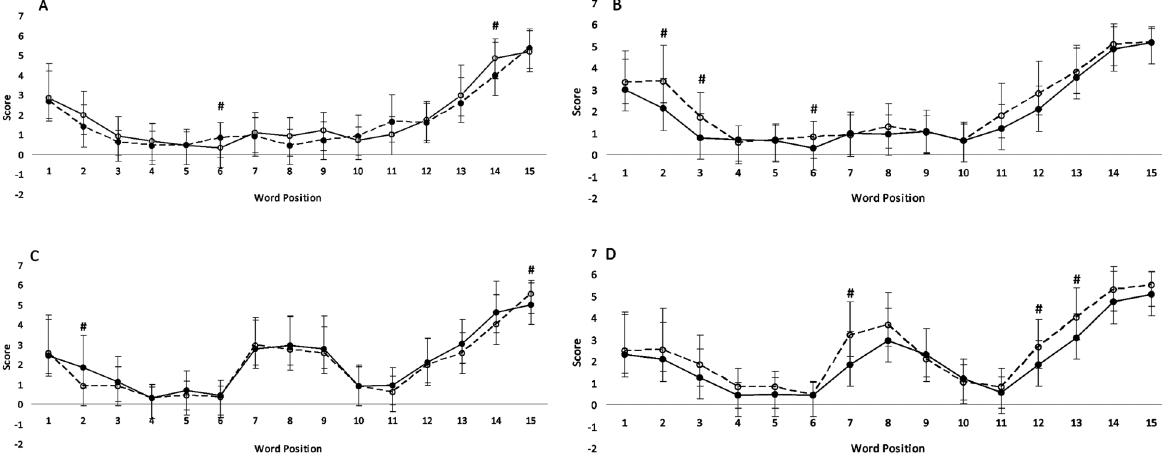
Figure 1. Serial curve position of Free Word Recall test. Assessments were made at baseline and post-training. A : Lists with no semantically related words, at baseline; B : lists with no semantically related words, post-training; C : lists with semantically related words, at baseline; D : lists with semantically related words, post-training. The scores of each position are reported as means ± SD. # P p 0.05 compared to control group (Student ’ s t -test for independent